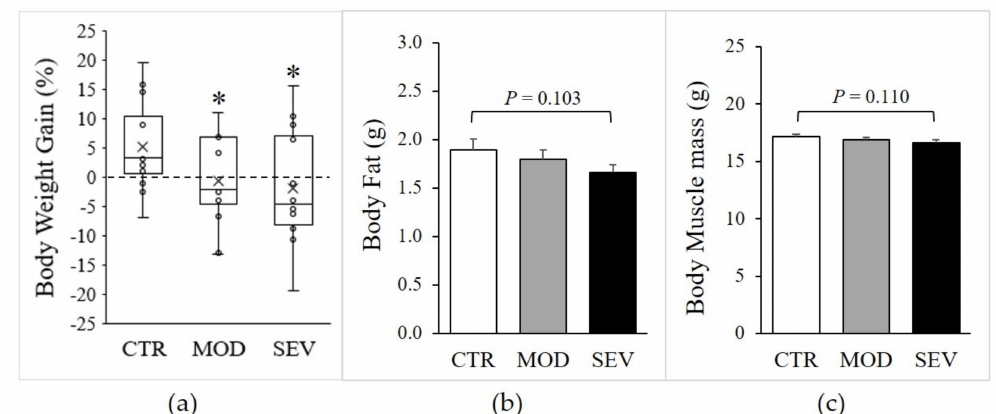
Figure 2. Body composition of mice fed Mg 2+ -deficient diet. Mice were fed either a control (CTR), a mildly (MOD), or a severely (SEV) Mg 2+ -deficient diet: ( a ) body weight, data (N = 12) presented as box-and-whisker plots, ( b ) body fat, and ( c ) body muscle mass were determined by EcoMRI; results are means + SE (N = 12). * Significant difference ( P < 0.05) from the CTR group.